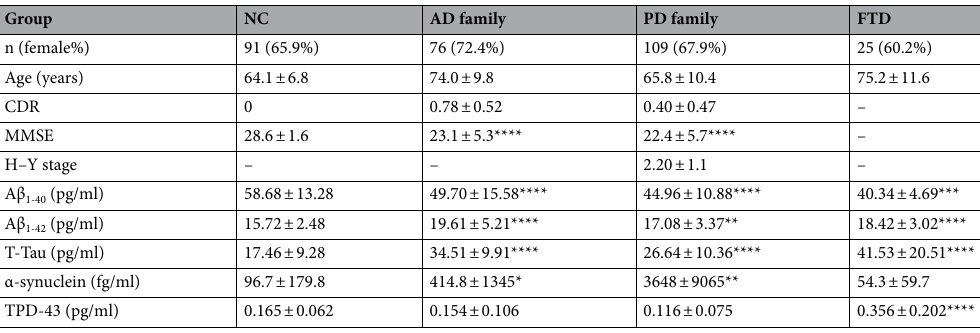
Table 1. Demographic information and measured concentrations of plasma biomarkers in enrolled subjects. NC normal control, AD family patients with amnestic cognitive impairment or Alzheimer’s disease, PD family Parkinson’s disease patients with or without dementia, FTD frontotemporal dementia, CDR clinical dementia ranking, MMSE mini-mental state examination, H–Y stage Hoehn and Yahr stage. * p < 0.05 using NC as reference. ** p < 0.01 using NC as reference. *** p < 0.001 using NC as reference. **** p < 0.0001 using NC as